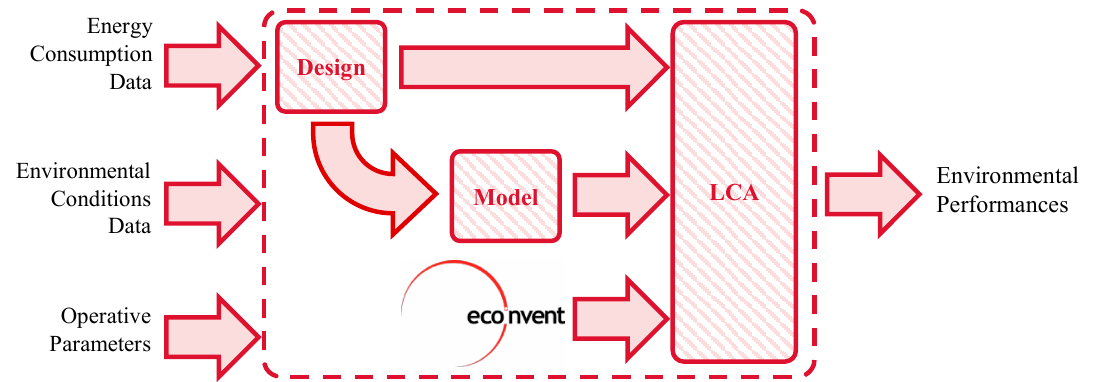
Figure 1. Flowchart of the three-steps methodology implemented in this work.